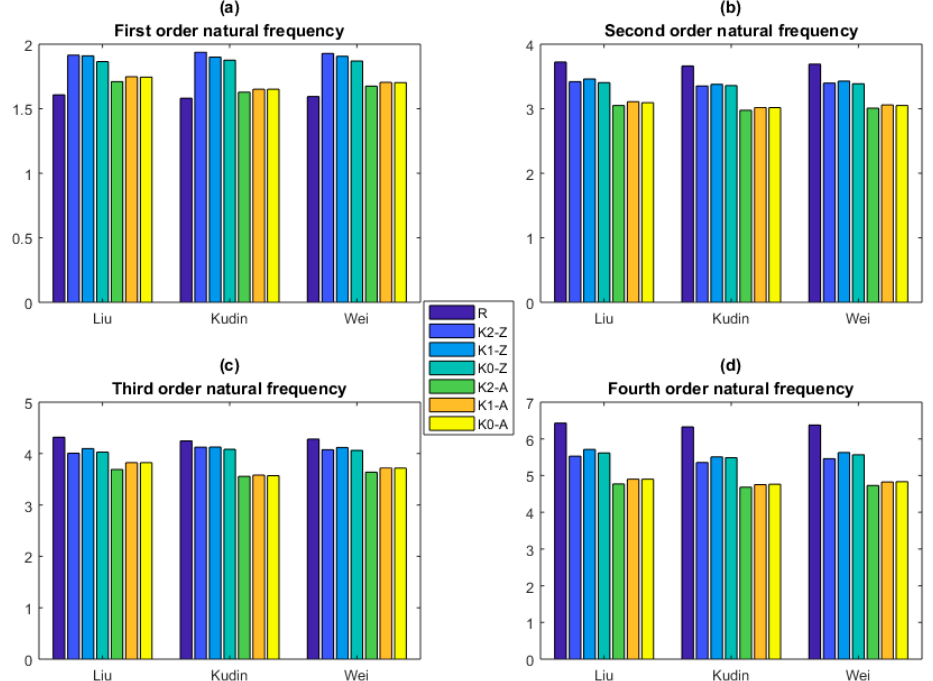
Figure 6. Comparison between the prediction results of KSM and that of DFT (the unit for the natural frequency is THz. K0–K2 are for the constant, linear, and quadratic functions. The Z and A are for Zigzag and Armchair graphene, respectively. ( a ), ( b ), ( c ) and ( d ) are the first four order natural frequencies, respectively.).